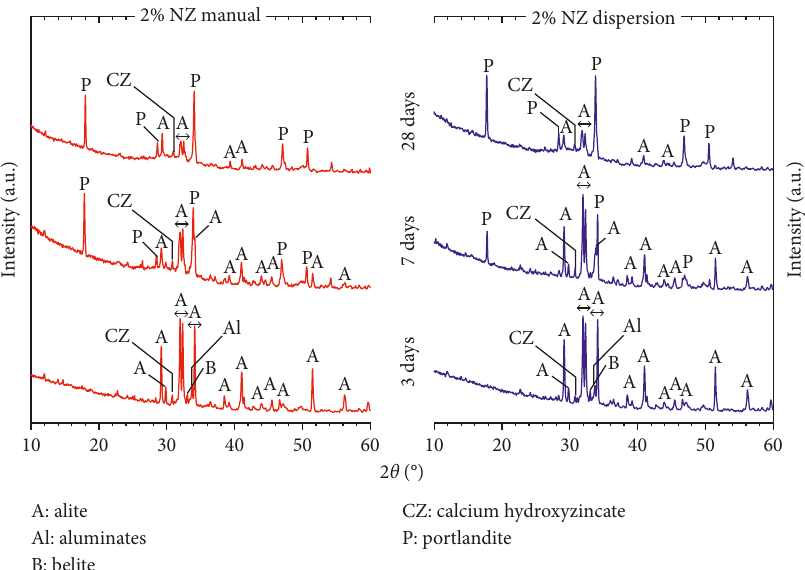
Figure 3: XRD characterization for cement paste with 2 wt.% of nanozinc